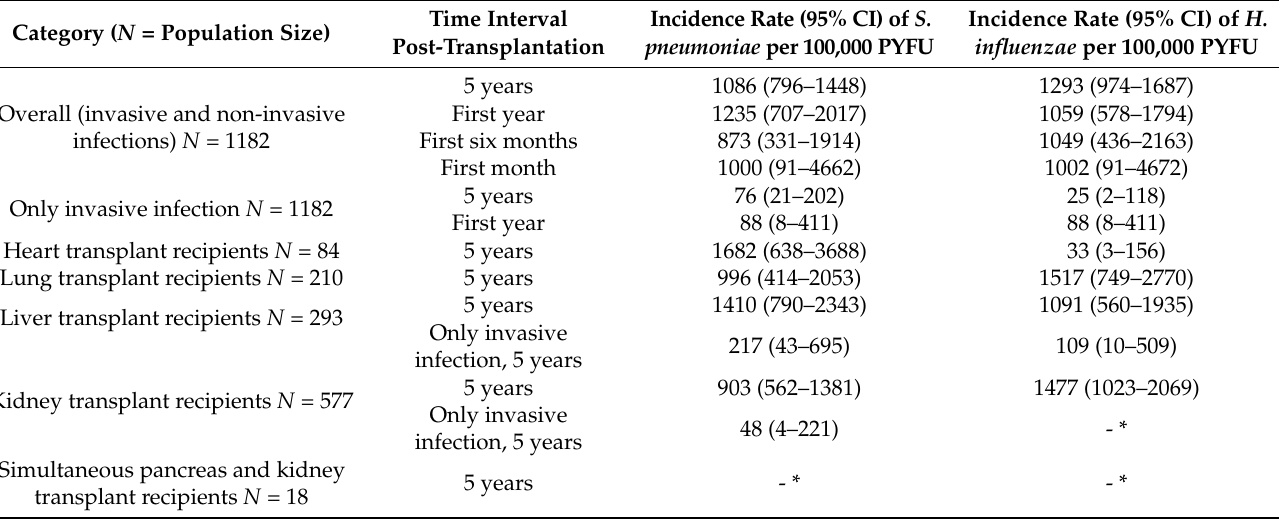
Table 2. Incidence rates of S. pneumoniae and H. influenzae